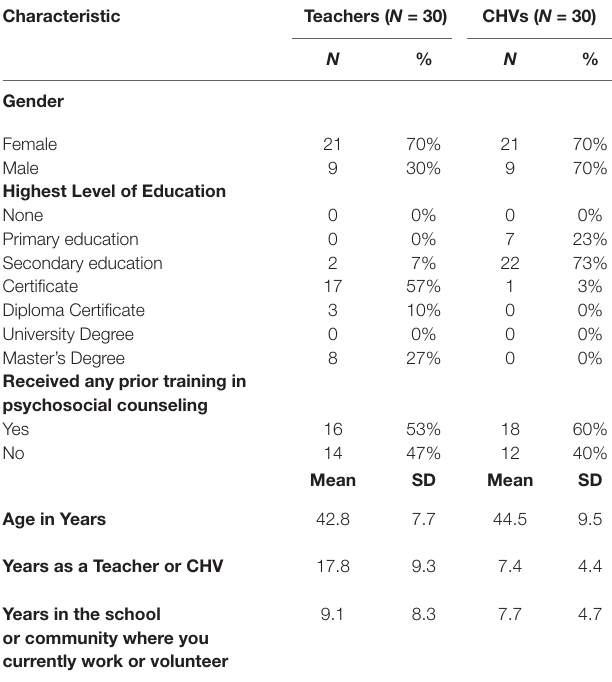
TaBLE 1 | Characteristics of Teacher Counselors and Community Health Volunteers (CHVs) Counselors from 10 clusters in the trial.